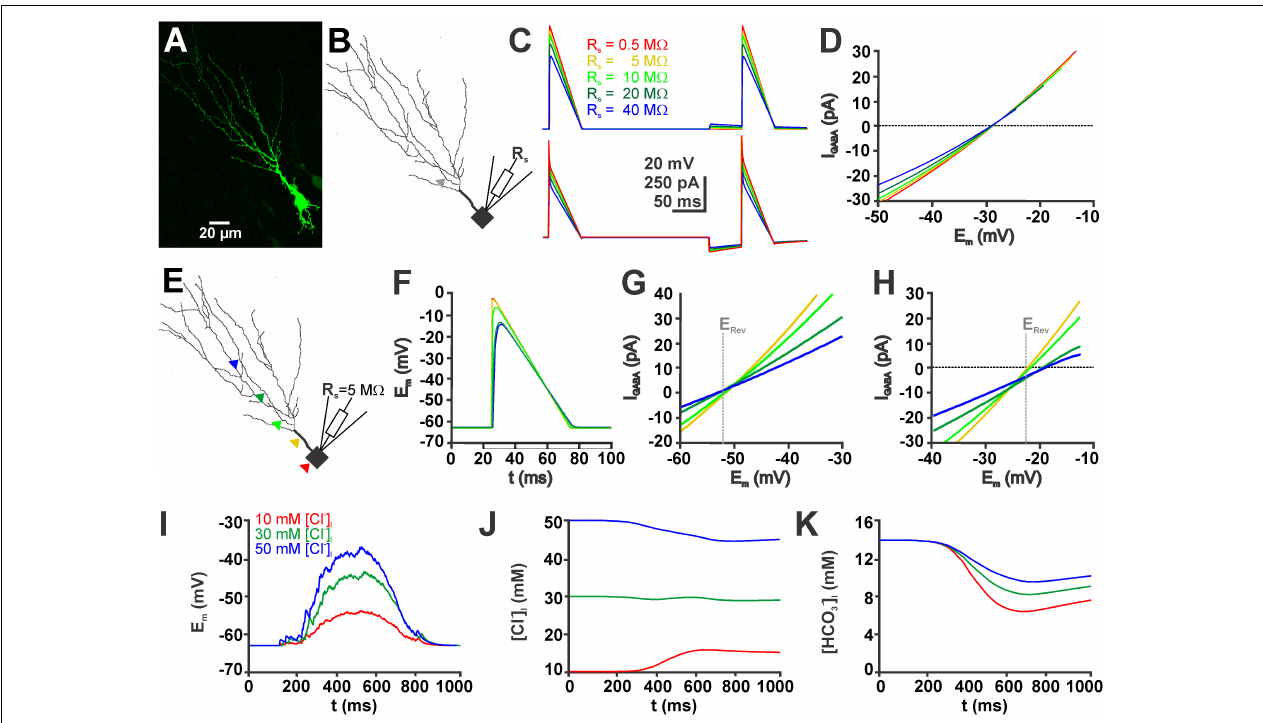
FIGURE 5 | Simulations in a biophysically realistic compartmental model of a CA3 pyramidal cell replicate the dependence of GDP-induced [Cl − ] i changes on initial [Cl − ] i . (A) Biocytin labeled CA3 neuron in a P4 mouse slice. (B) Somatodendritic reconstruction of this cell. The gray arrowhead indicates the site of the GABAergic synapse used in (C,D) . Voltage-clamp was simulated using the single-electrode voltage-clamp process of NEURON. (C) Voltage (top) and current (bottom) traces